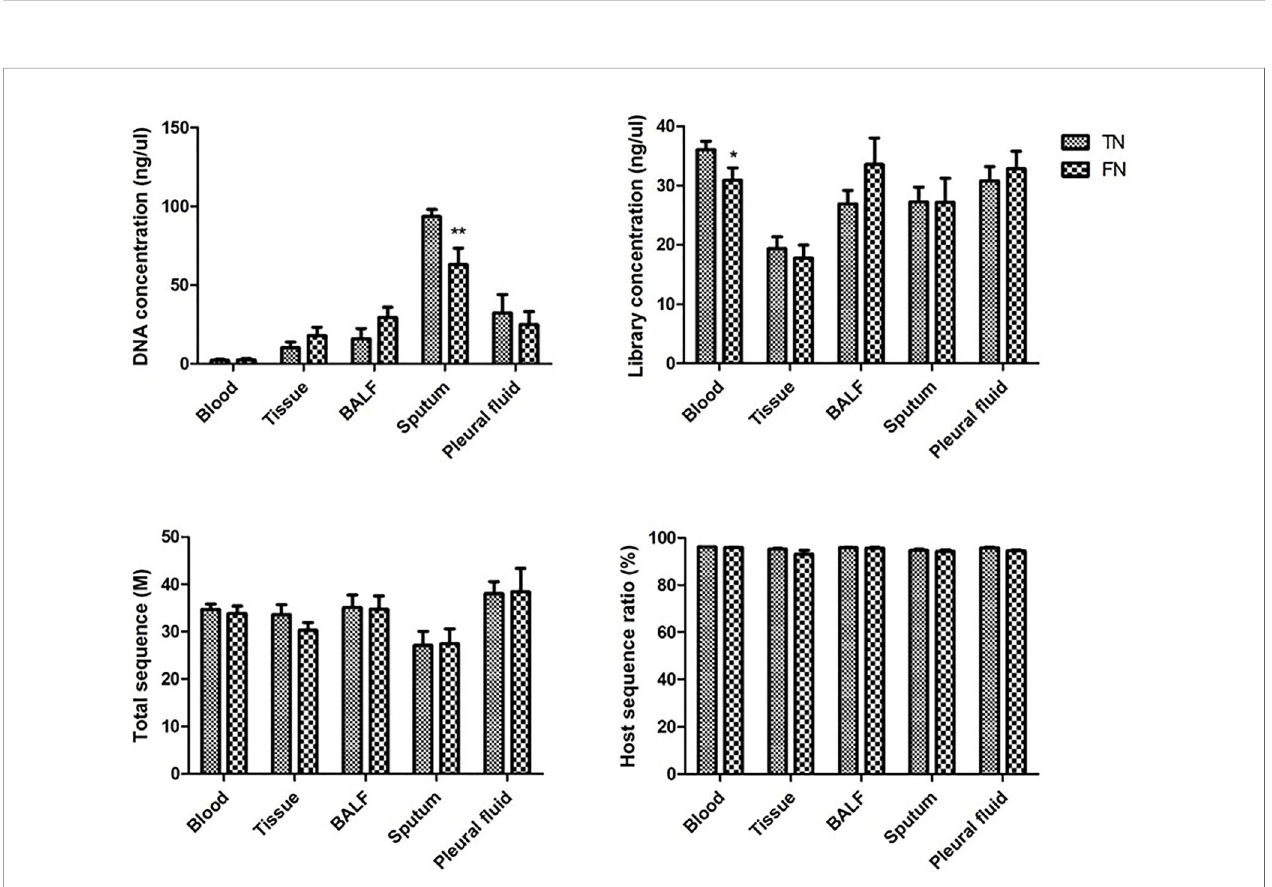
FIGURE 6 | Comparison of experimental data between TN and FN samples. DNA concentration, library concentration, total sequence, and host sequence ratio were compared between TN and FN samples in blood, tissue, BALF, sputum, and pleural fl uid. * p < 0.05, statistical difference. ** p < 0.01, signi fi cant statistical difference. BALF, bronchoalveolar lavage fl uid; TN, true negative; FN, false